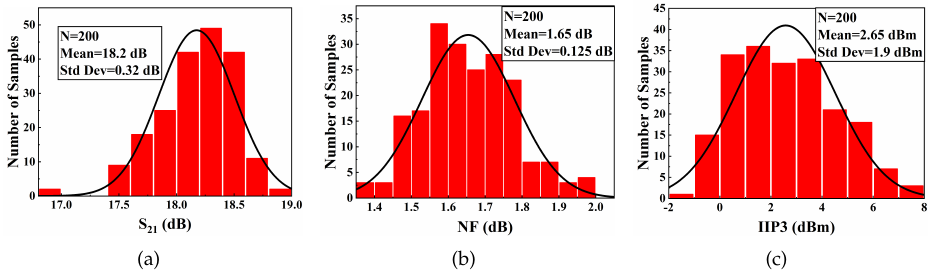
Figure 18. Monte Carlo simulations of the proposed LNA for 200 samples. ( a ) gain; ( b ) noise figure; ( c ) IIP3.